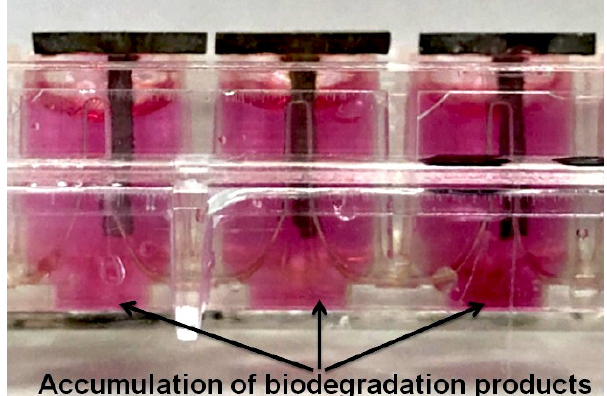
Figure 1. Accumulation of biodegradation products of samples of alloy WE43 in initial state and after MAD in the immersion medium. The samples were placed in the wells of the special 16-well plates vertically so as to be partially immersed in the fetal bovine serum or the complete growth medium, and did not touch the bottom. The plate with alloy samples was incubated in the xCELLigence RTCA Systems analyzer at 37 °C in an atmosphere of 5% carbon dioxide. The device measured an electrical impedance ( Δ I) due to the accumulation of alloy degradation products at well bottom every 15 min for 288 h.